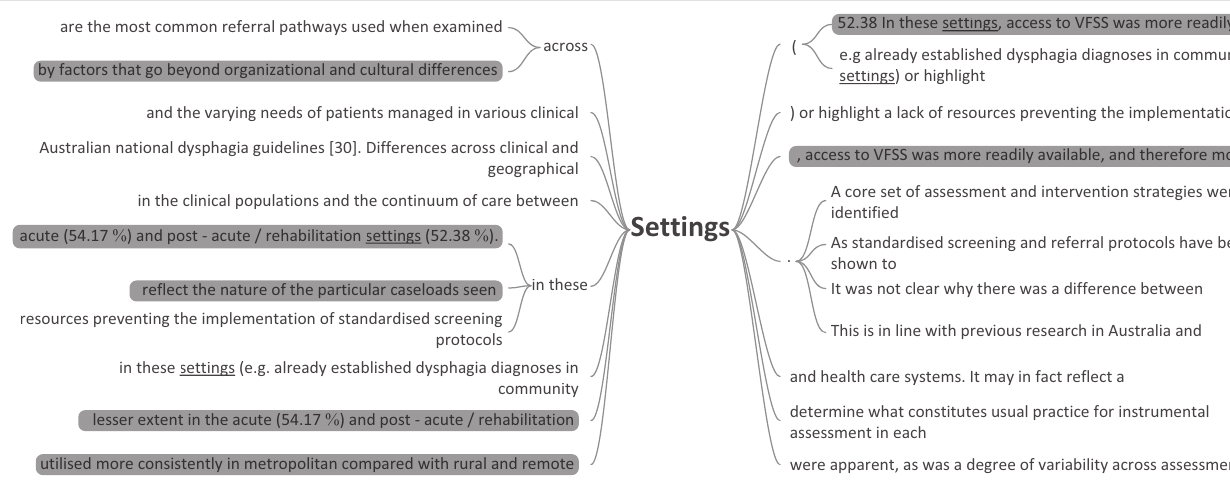
FIGURE 4: Word tree representing setting data, generated in NVivo 12.